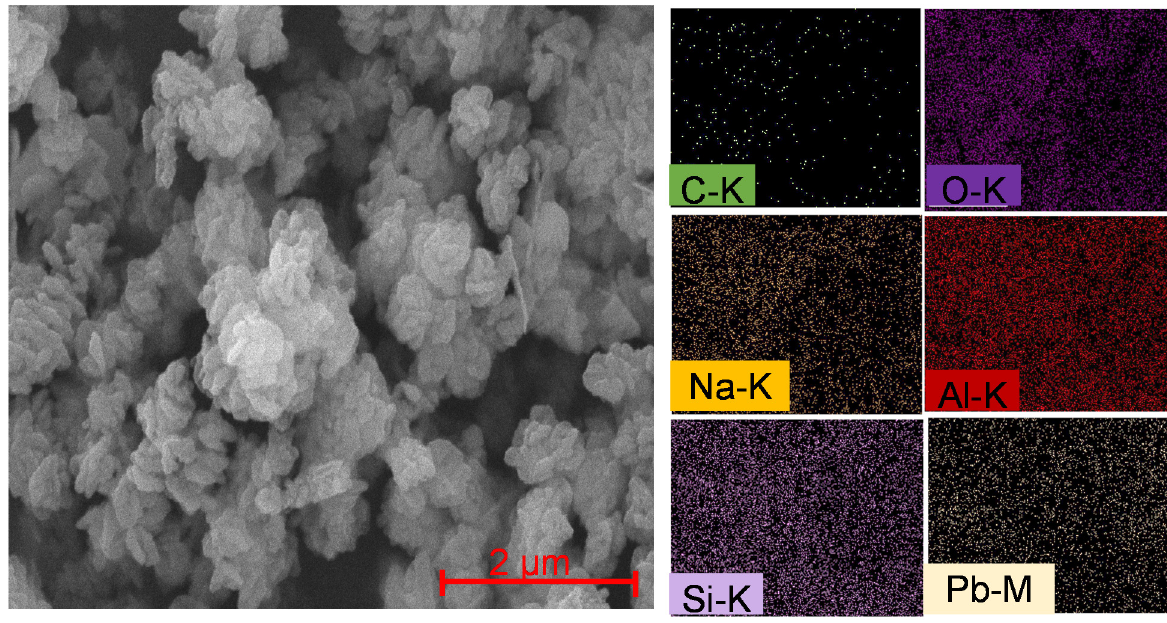
Figure 10. SEM-EDX analysis of S80H9 after Pb 2+ adsorption.